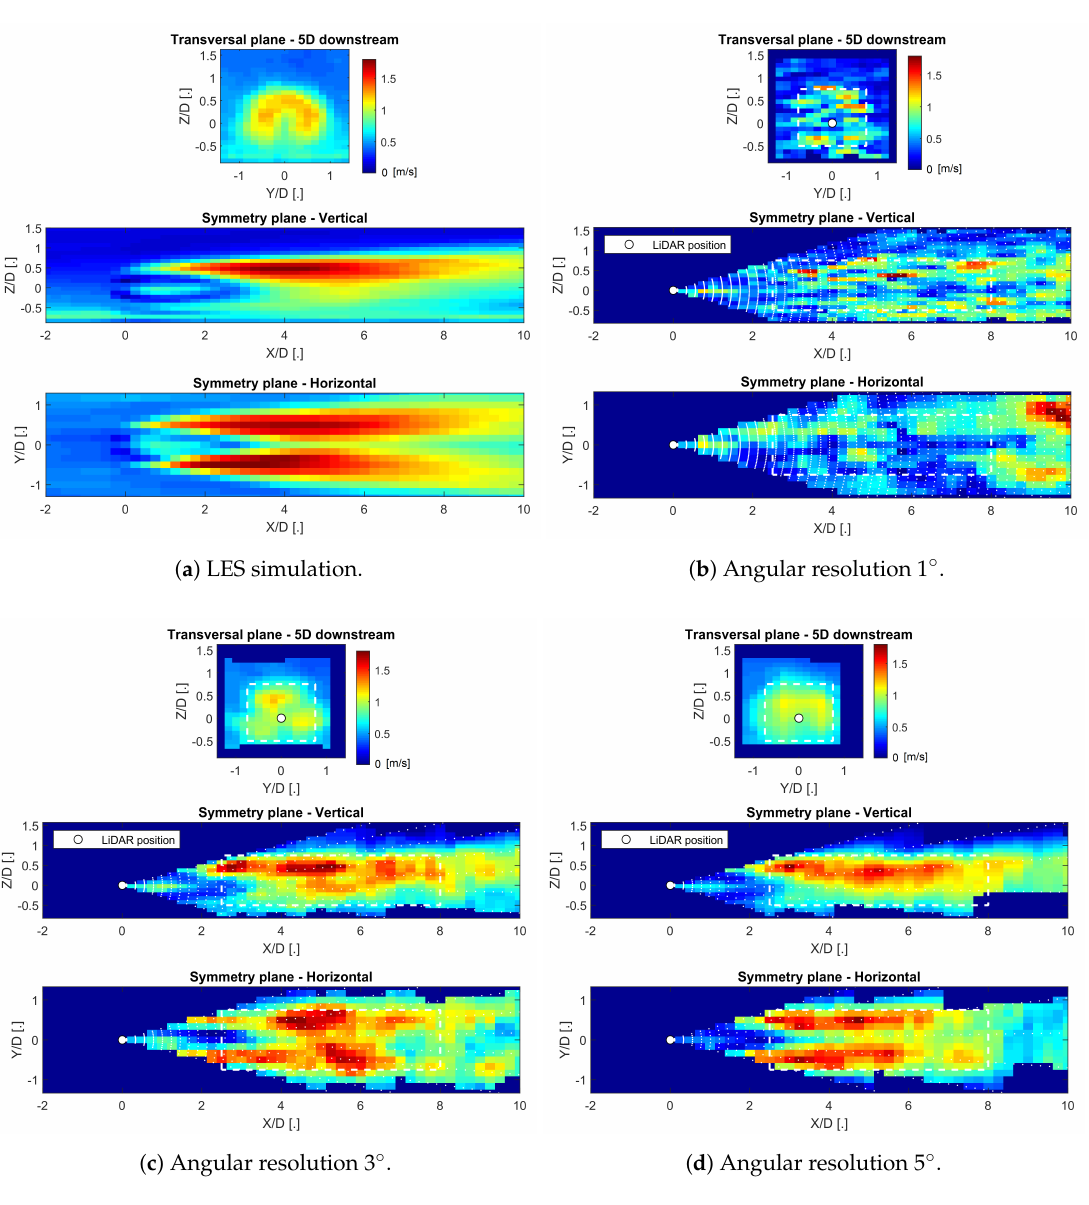
Figure 5. σ u ( x , y , z ) from ( a ) LES simulations and an example of its reconstruction using three different angular resolutions: ( b ) 1 ◦ , ( c ) 3 ◦ , and ( d ) 5 ◦ . The example corresponds to the MV-MT inflow case and to the nacelle-mounted lidar. The volume of interest is delimited by the white dashed line, and spherical grid points are marked as white dots. The figures show the magnitude of σ u ( x , y , z ) in m/s. Table 6 shows only the errors associated with an angular resolution of 3 ◦ . The errors are close in magnitude, although slightly higher, to the errors of u ( x , y , z ) (see Table 5). This fact might induce some confusion when comparing them. However, it should be noted that the values of σ u are significantly smaller than the values of u , so the accuracy of the calculation of the standard deviations is considerably poorer than that of the mean velocity. It can also be observed that a nacelle-mounted lidar offers a slightly better performance than a ground-based